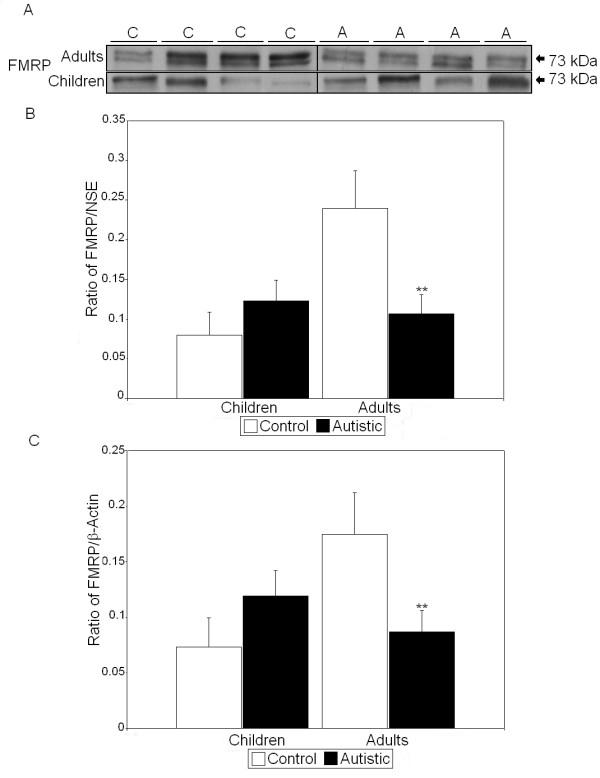
Expression of FMRP in superior frontal cortex of people with autism and matched controls.(A) Representative samples of fragile X mental retardation protein (FMRP) from controls (C) and people with autism (A). (B) Mean FMRP/neuron-specific enolase (NSE) ratios for people with autism (filled histogram bars) and controls are shown for Brodmann's area 9 (BA9). (C) Mean FMRP/β-actin ratios for people with autism (filled histogram bars) and controls are shown for BA9. Error bars express standard error of the mean. **P < 0.05.